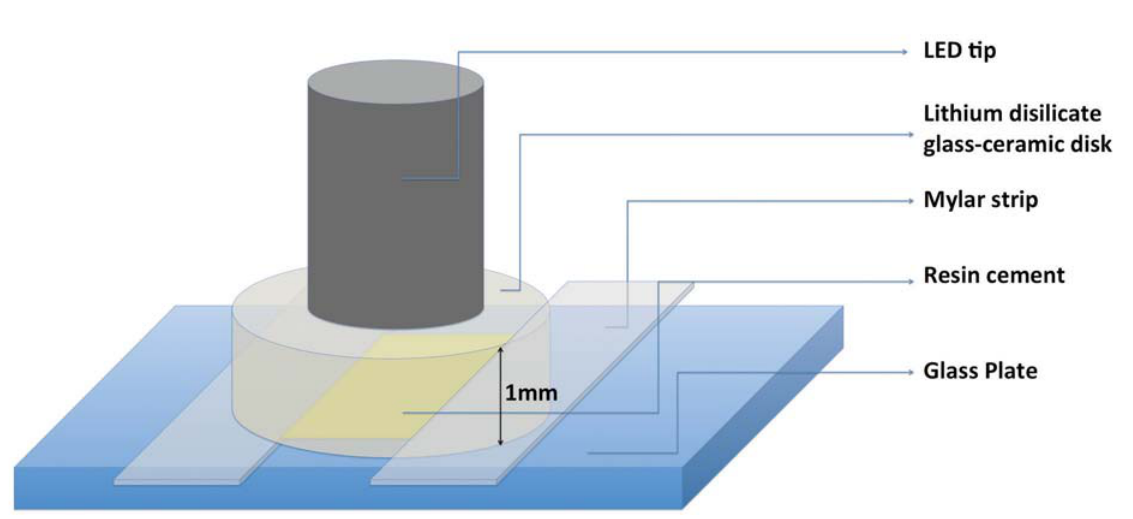
Figure 1- Brand, composition, and batch number of the materials